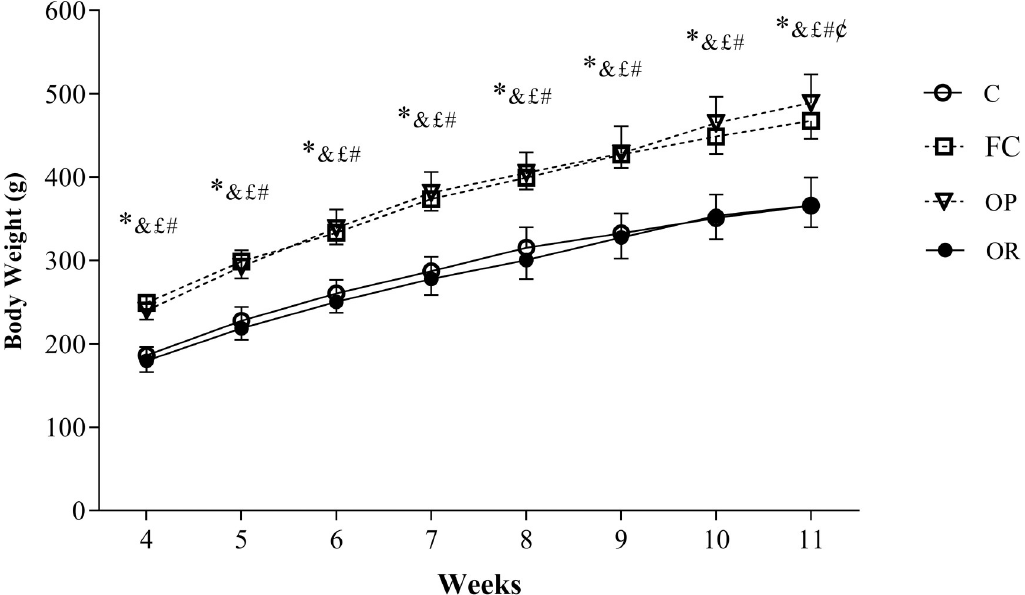
Fig 2. Evolution of body weight after application of the tercile criterion (week 3) for redistribution of groups in Control (C, n = 15), false-control (FC, n = 16); obesity-prone (OP, n = 16) and obesity-resistant (OR, n = 16). Data expressed as mean ± standard deviation. p < 0.05 - � OP vs . C; & C vs . FC; # OP vs . OR; ¢ OP vs . FC; £ FC vs . OR, repeated measures two-way ANOVA followed by Tukey’s post-hoc